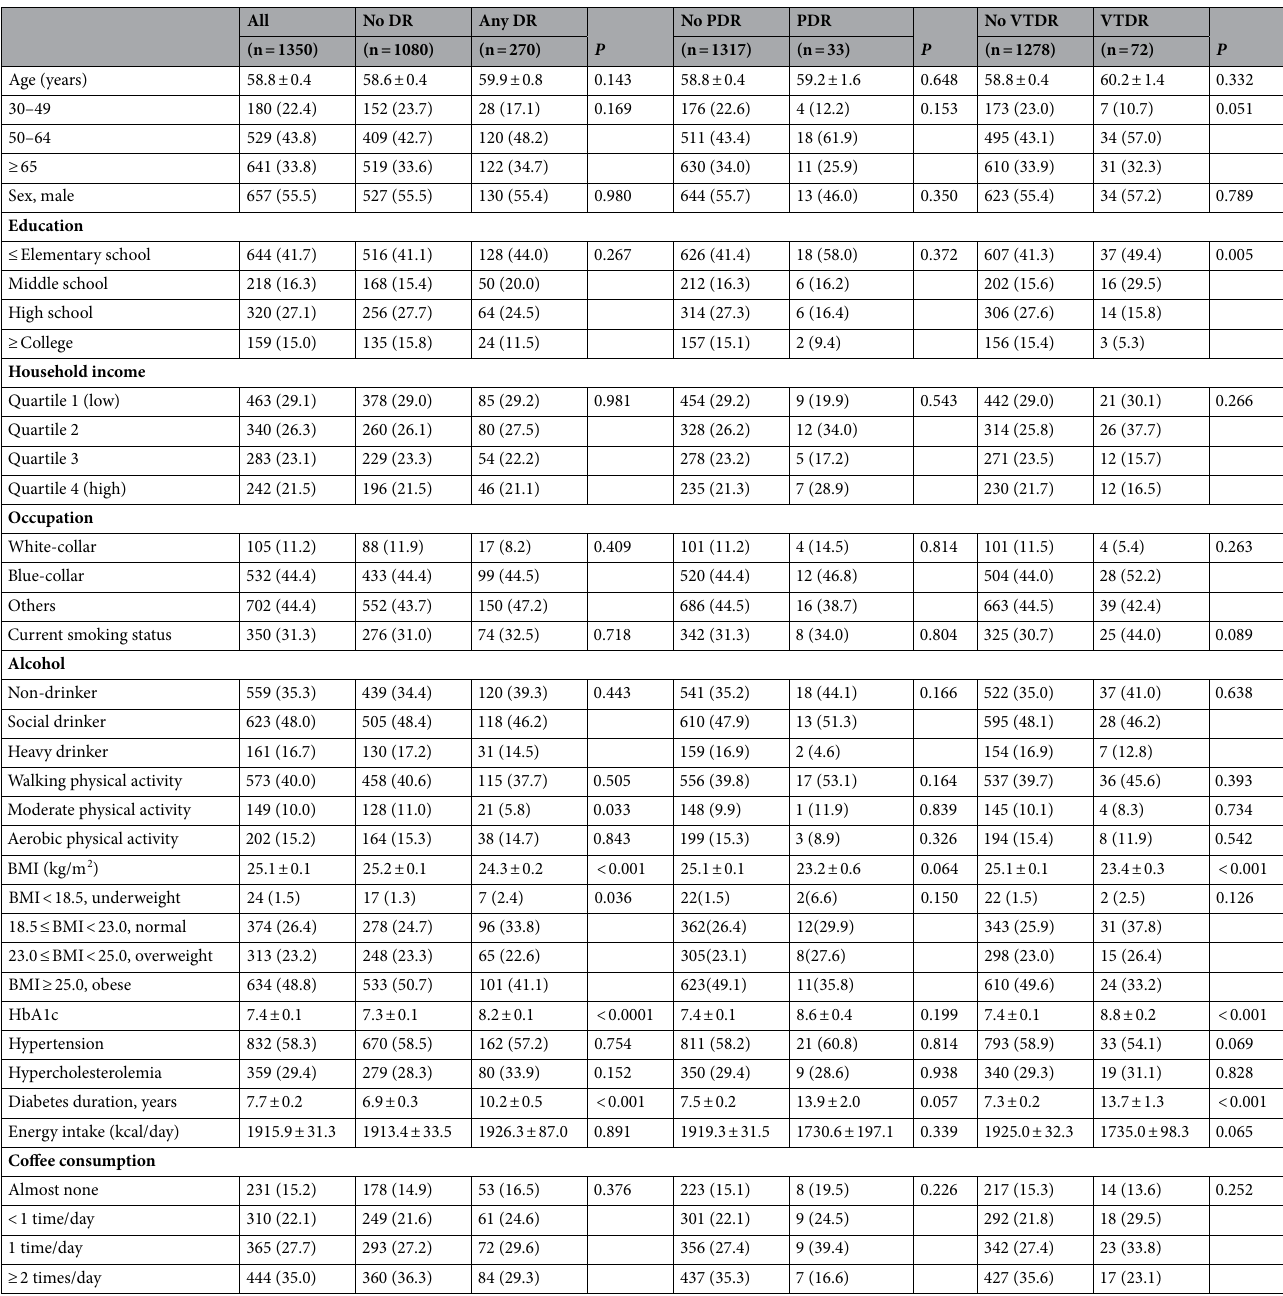
Table 1. General characteristics of DR in patients with type 2 diabetes (n = 1,350). Data are expressed as means ± standard errors for continuous variables or numbers (proportions) for categorical variables. P values were based on the Wilcoxon rank-sum test for continuous variables and the chi-square test for categorical variables. DR, diabetic retinopathy; BMI, body mass index; HbA1c, glycated hemoglobin; PDR, proliferative diabetic retinopathy; VTDR, vision-threatening diabetic